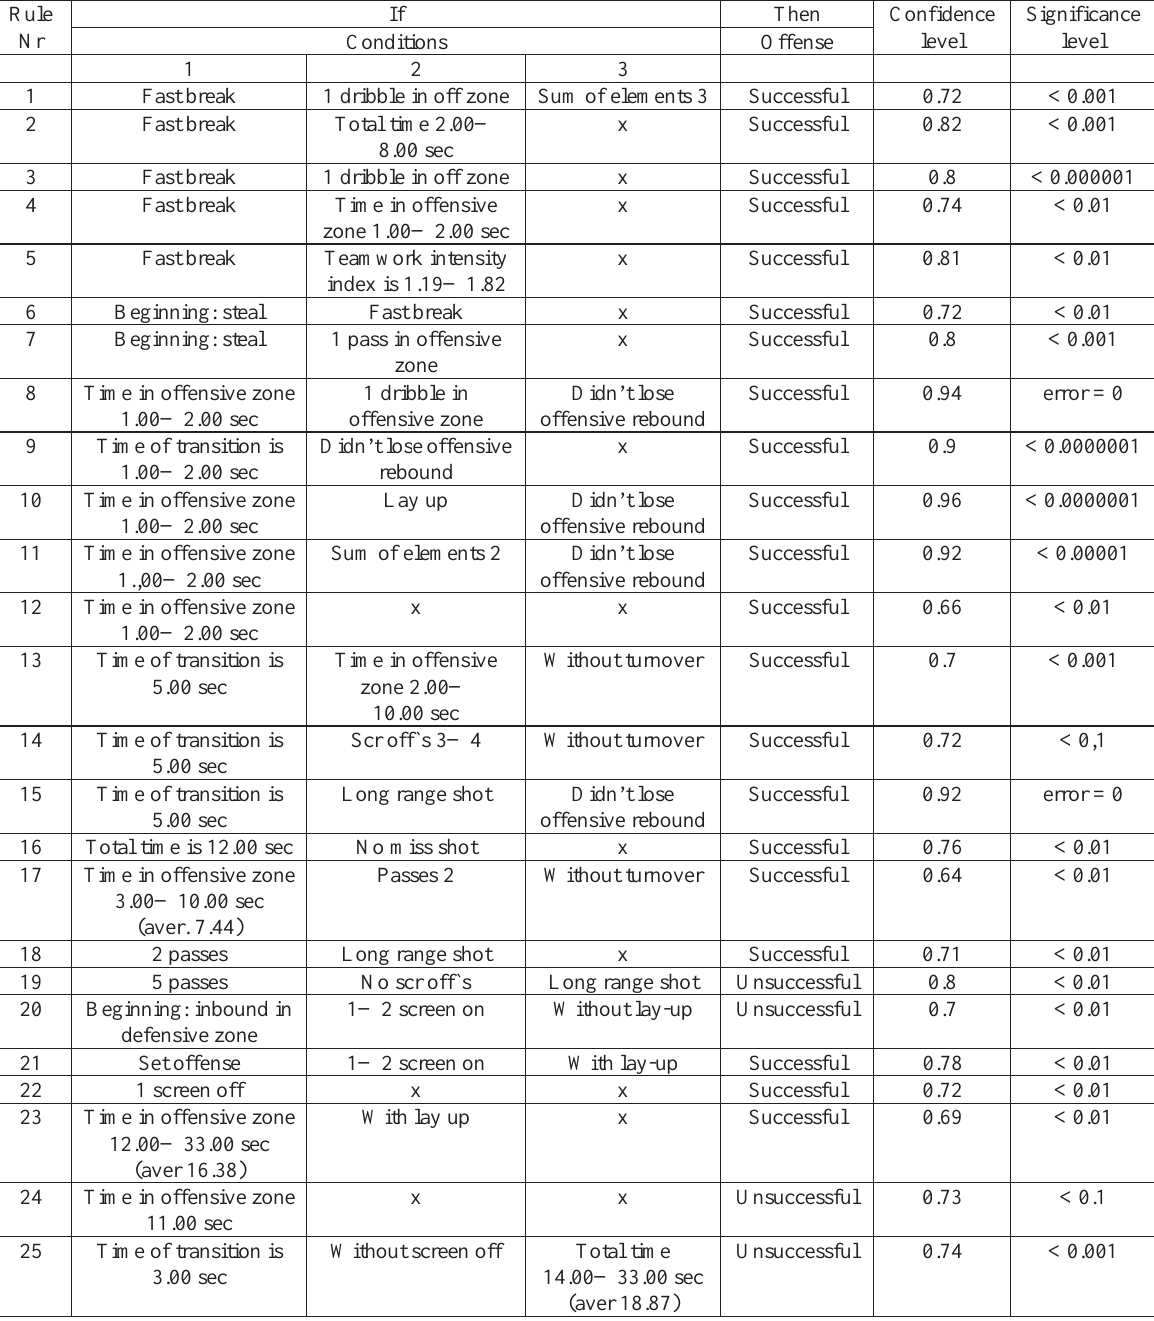
Table 1. If-then rules for the scoring more than 1.13 points per